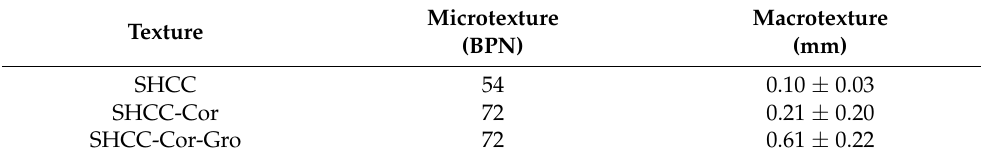
Table 4. Microtexture and macrotexture for SHCC, modified SHCC-Cor, and